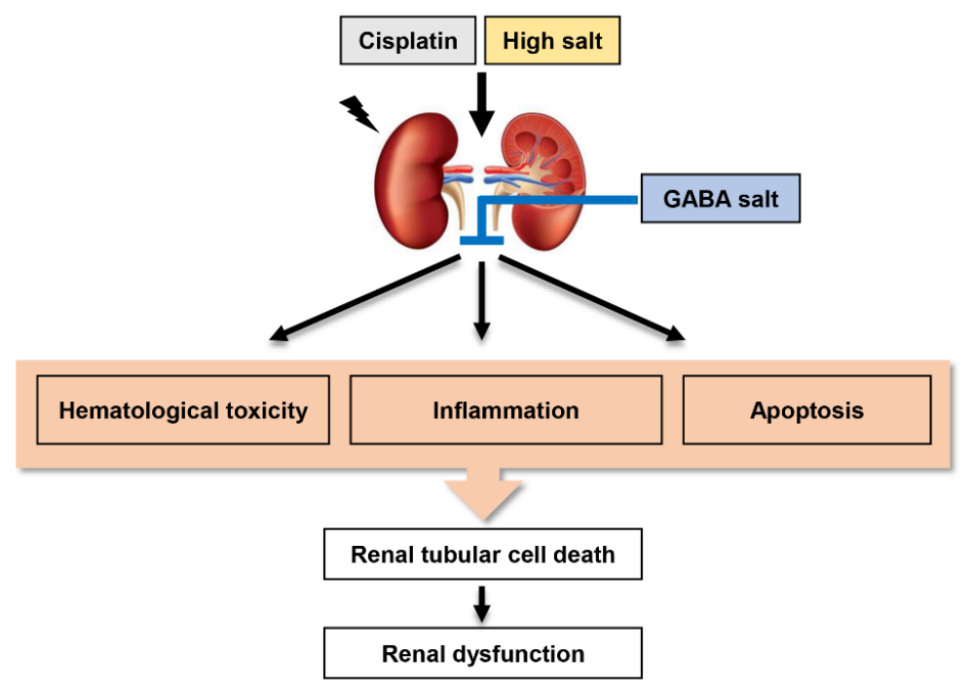
Figure 5. Schematic diagram of potential role of GABA-enriched salt in the negative effect of high salt intake on cisplatin-induced renal toxicity. GABA has a protective ability against negative effect of high salt intake in cisplatin-induced renal toxicity. Its mechanism involves suppression of hematological and biochemical toxicity, apoptosis, and inflammation.